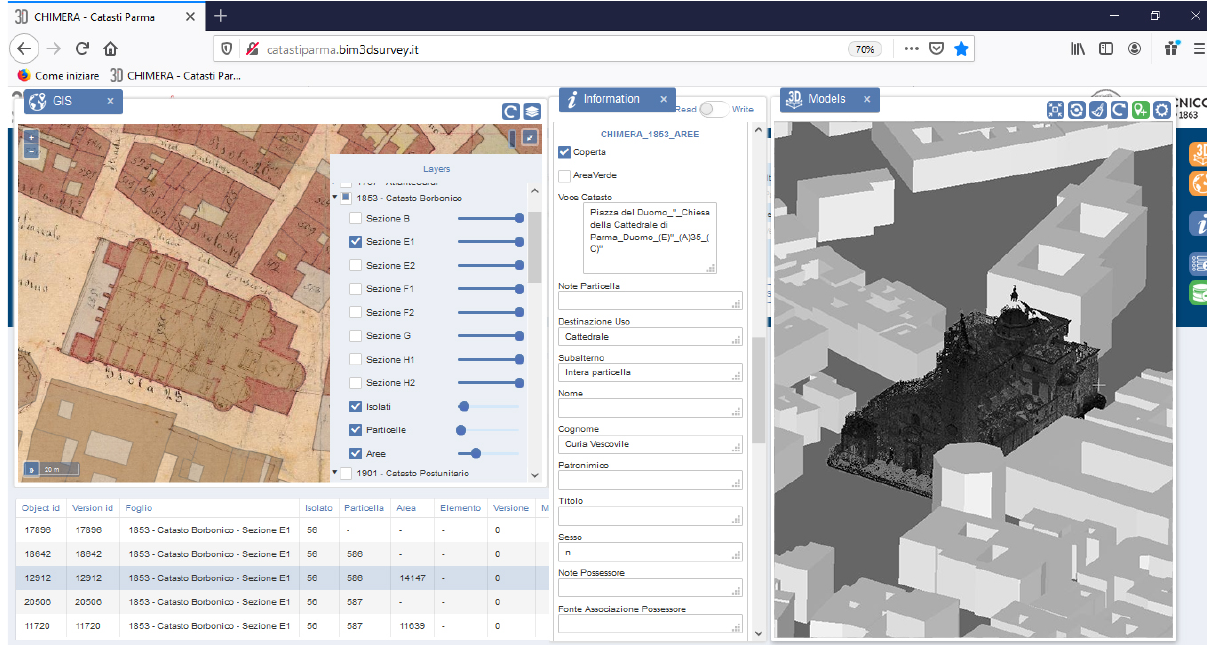
Figure 4. Image shows data about the Cathedral. On the left, the 2D interface displays the 1853 historical map, with vector polygons representing blocks, parcels and buildings superimposed as layers with different transparency. In the center, the data sheet shows information referred to the Cathedral in 1853. On the right, the 3D model (LOD1) of the whole city and the 3D point cloud of the Cathedral, referring to the current period, are